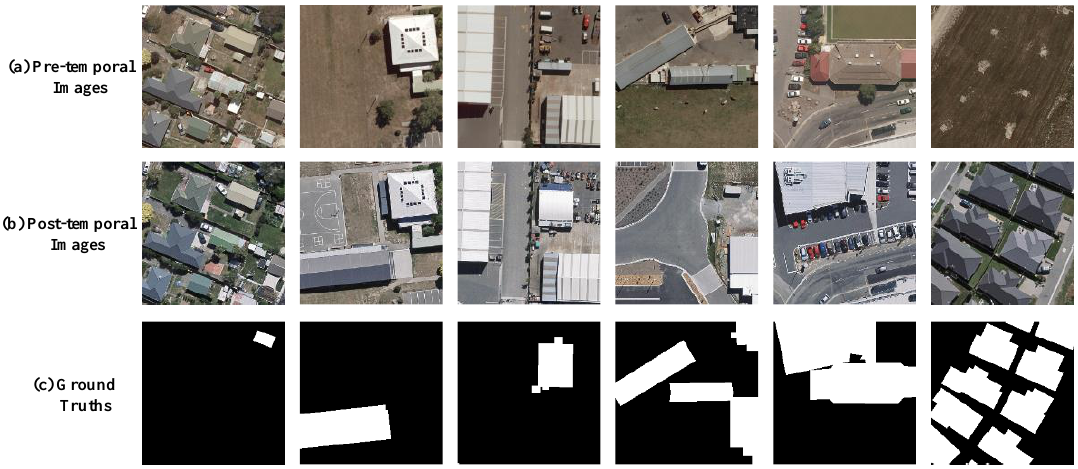
Figure 5. A demonstration of six scenarios from the WHU-CD dataset.